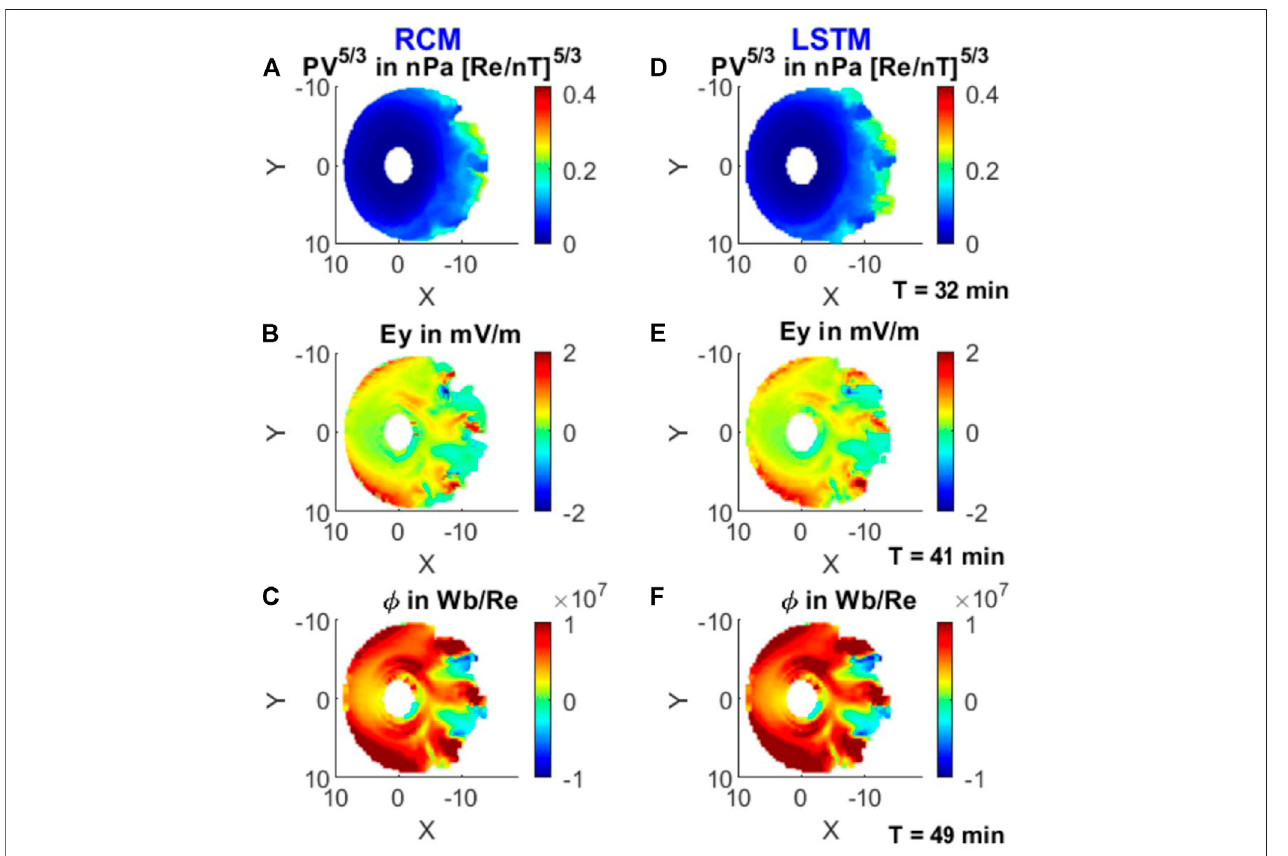
FIGURE 11 | Similar to Figure 10 , but for the three- fl ow-channel